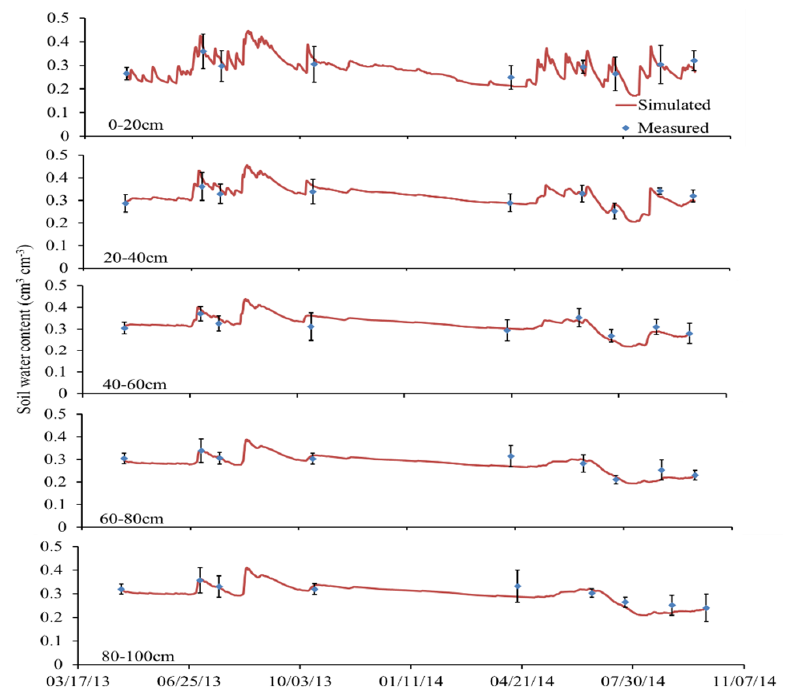
Figure 1. Comparison of simulated and measured soil water content at different depths under N312 treatment in loamy clay soil.